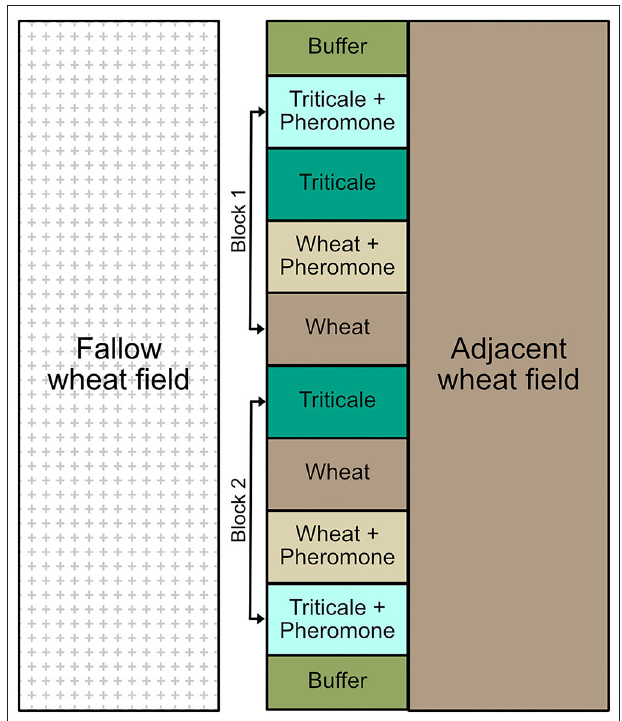
FIGURE 1 | Field plot design in 2019, showing blocks 1 and 2 as examples. We had a total of 12 replications and two buffer plots. Plots were 31m each. In 2020 pheromone was not added to plots but field design was otherwise